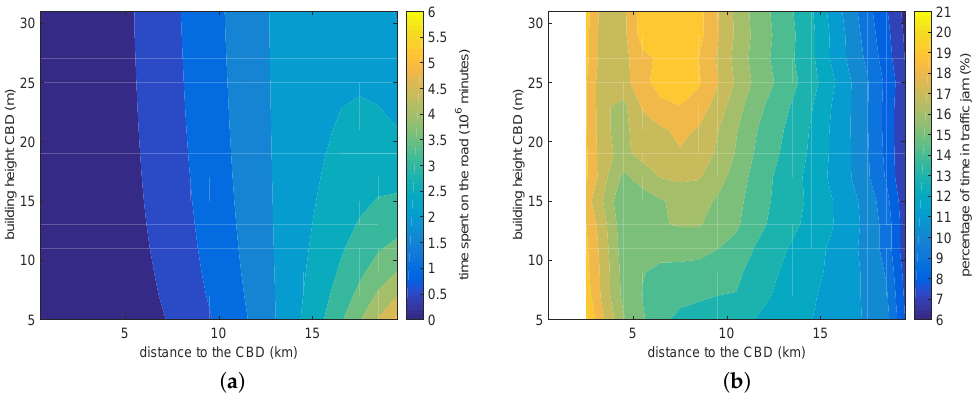
Figure 10. ( a ) Total time spend on the road; and ( b ) percentage of time spend in a traffic jam with respect to the total commuting time as a function of building height in the CBD H CBD and distance from home to the